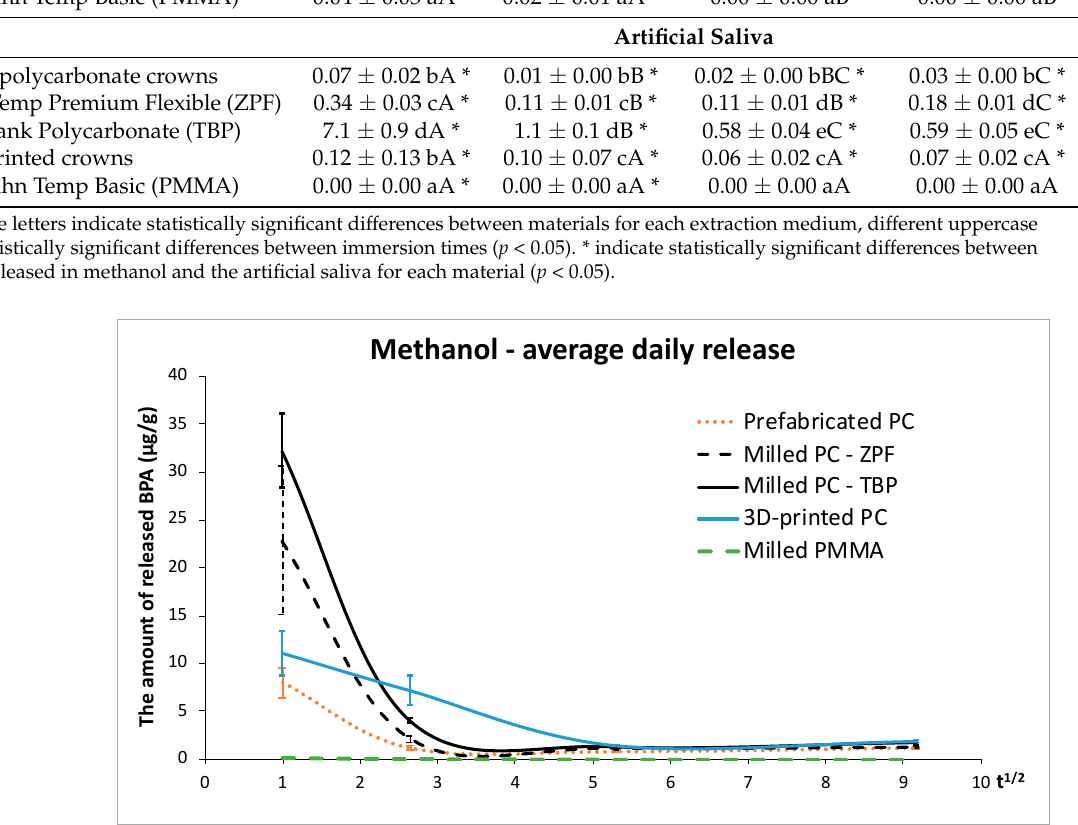
Figure 3. Average daily release of BPA in methanol ( μ g/g). The values are plotted against the square root of time, assuming that the release of BPA follows Fick’s law of diffusion. Abbreviations: PC—polycarbonate, ZPF—Zirkonzahn Temp Premium Flexible, TBP—Tizian Blank Polycarbonate, PMMA—poly(methyl methacrylate) (Zirkonzahn Temp